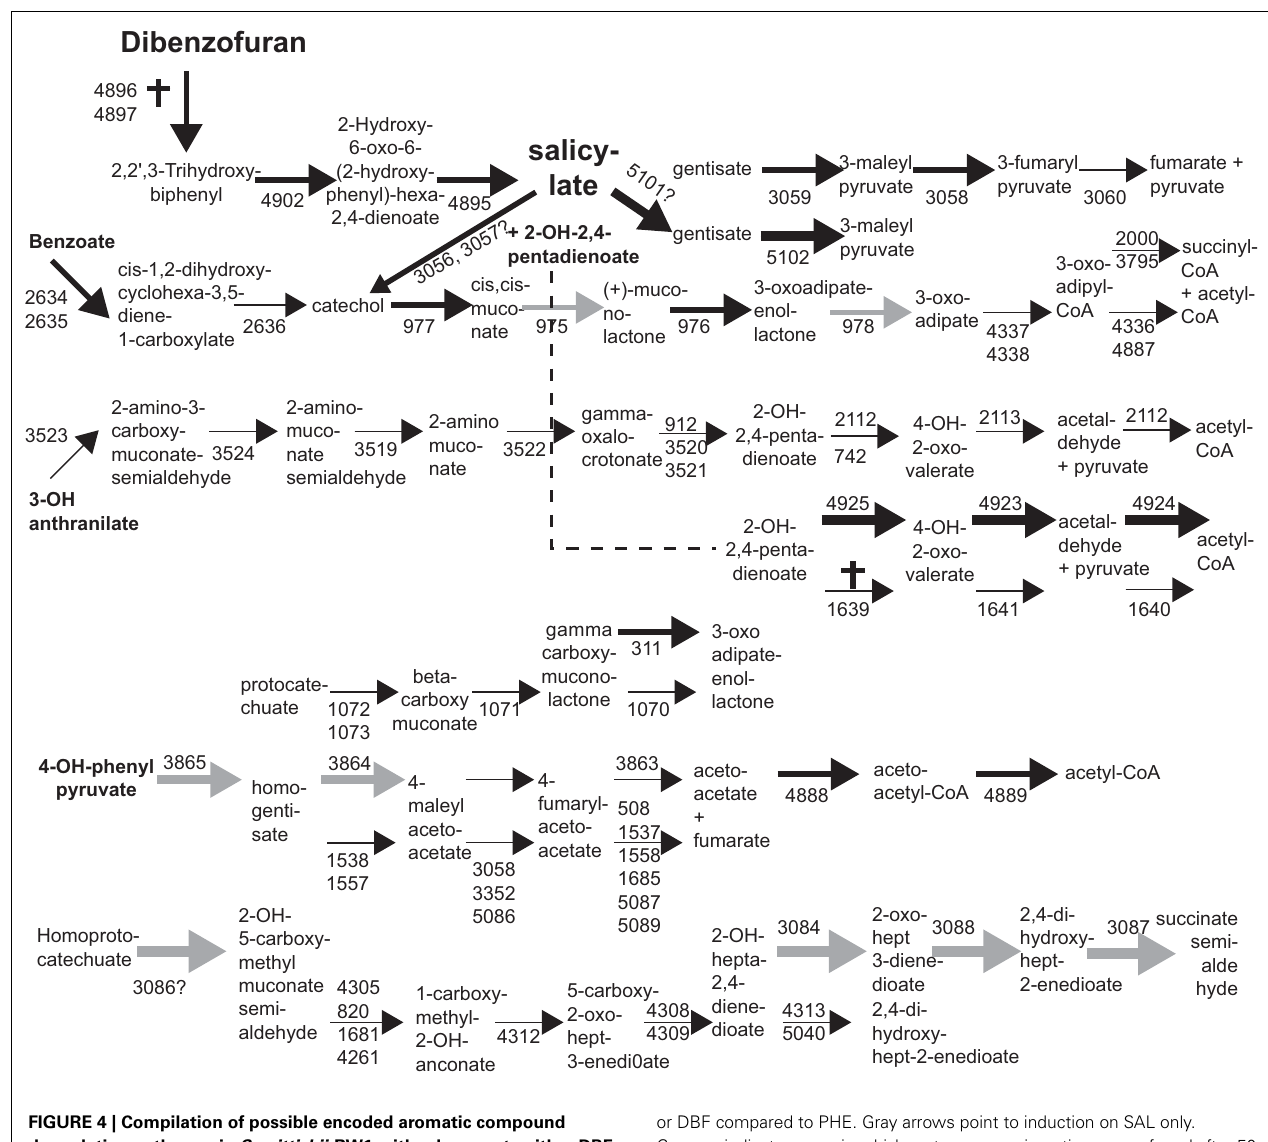
FIGURE 4 | Compilation of possible encoded aromatic compound degradation pathways in S. wittichii RW1 with relevance to either DBF or SAL metabolism. Numbers below arrows correspond to gene names (e.g., Swit_5101).Thick arrows indicate gene induction during growth on SAL